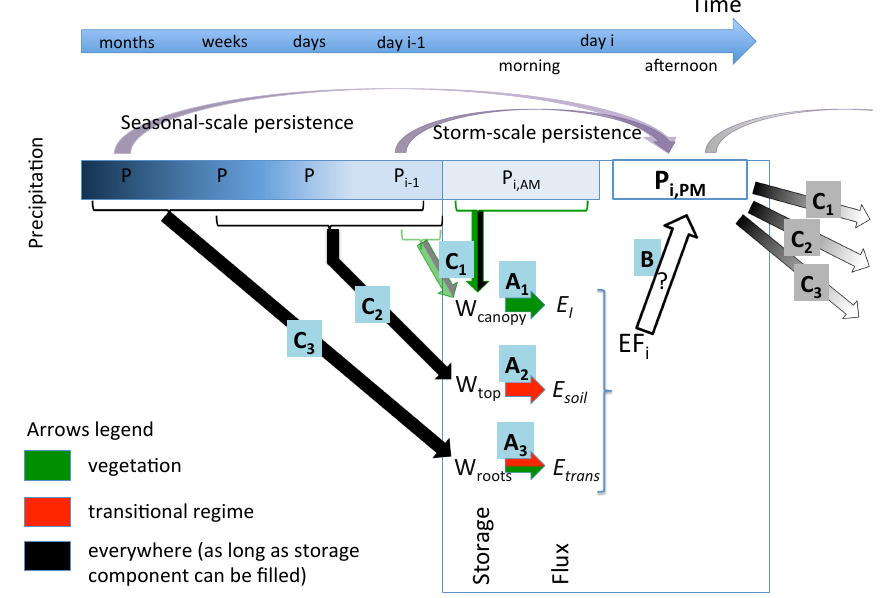
Figure 9. Different water storage components contributing to λE and their potential relevance for afternoon convective precipitation. The letters (A i , B i , C i ) refer to the steps of the feedback loop shown in Fig. 1, where “ i ” indicates the evaporation component of concern (1 for evaporation from vegetation interception, E I ; 2 for bare soil evaporation, E soil ; 3 for plant transpiration, E trans ). The horizontal axis represents time, ending with day i , and precipitation over the past days to months is represented with its persistence timescales and its typical influence on the three water storage terms shown below: canopy or vegetation interception storage W canopy is affected by precipitation over the previous hours only (C 1 ). Surface soil moisture W top is impacted by precipitation in the previous days to weeks (C 2 ). Root-zone soil moisture W roots is mainly impacted by precipitation in the previous weeks to months (C 3 ). These three storages control their respective evaporation components, and thus EF, in different regions. Over vegetated areas for interception (A 1 ), in a transitional soil-moisture–climate regime for soil evaporation (A 2 ), and in regions which are both vegetated and in a transitional climate regime for transpiration (A 3 ). Note that A 2 and A 3 can also occur in other regions in some circumstances (e.g., over wet regions, during dry years), and W roots includes W top . Note that for loop 1 (through interception), a coupling cannot be distinguished from storm-scale precipitation persistence as before-noon interception is only expected in the presence of morning rain, mainly reflecting precipitation of synoptic origin. Precipitation over the previous evening usually does not affect before-noon W canopy , but a transparent arrow is shown for rare cases where this might happen. Step B of the feedback remains a single component as the three evaporation components combine and only the total heat fluxes and their partitioning matter to precipitation